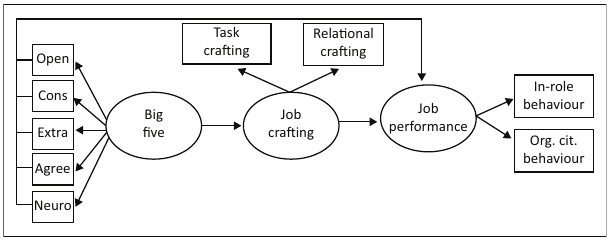
FIGURE 1: Hypothesised research